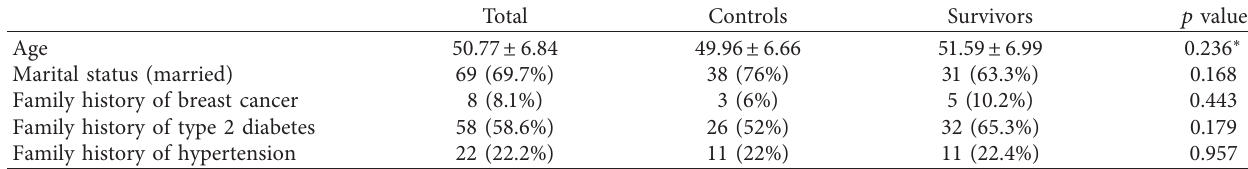
Table 2: General characteristics of controls and BC survivors.